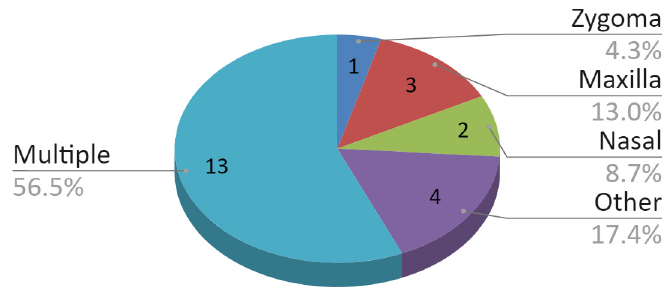
Figure 7. Division of coexisting non ‐ mandibular bone fractures.